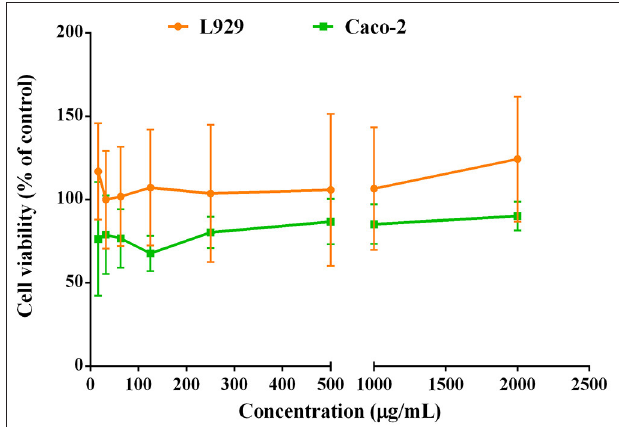
FIGURE 5 | Cell toxicity of ohmic heating ethanolic extract from Rotonda’s Red eggplant, using normal skin fibroblast cells (L929) and colorectal adenocarcinoma cells